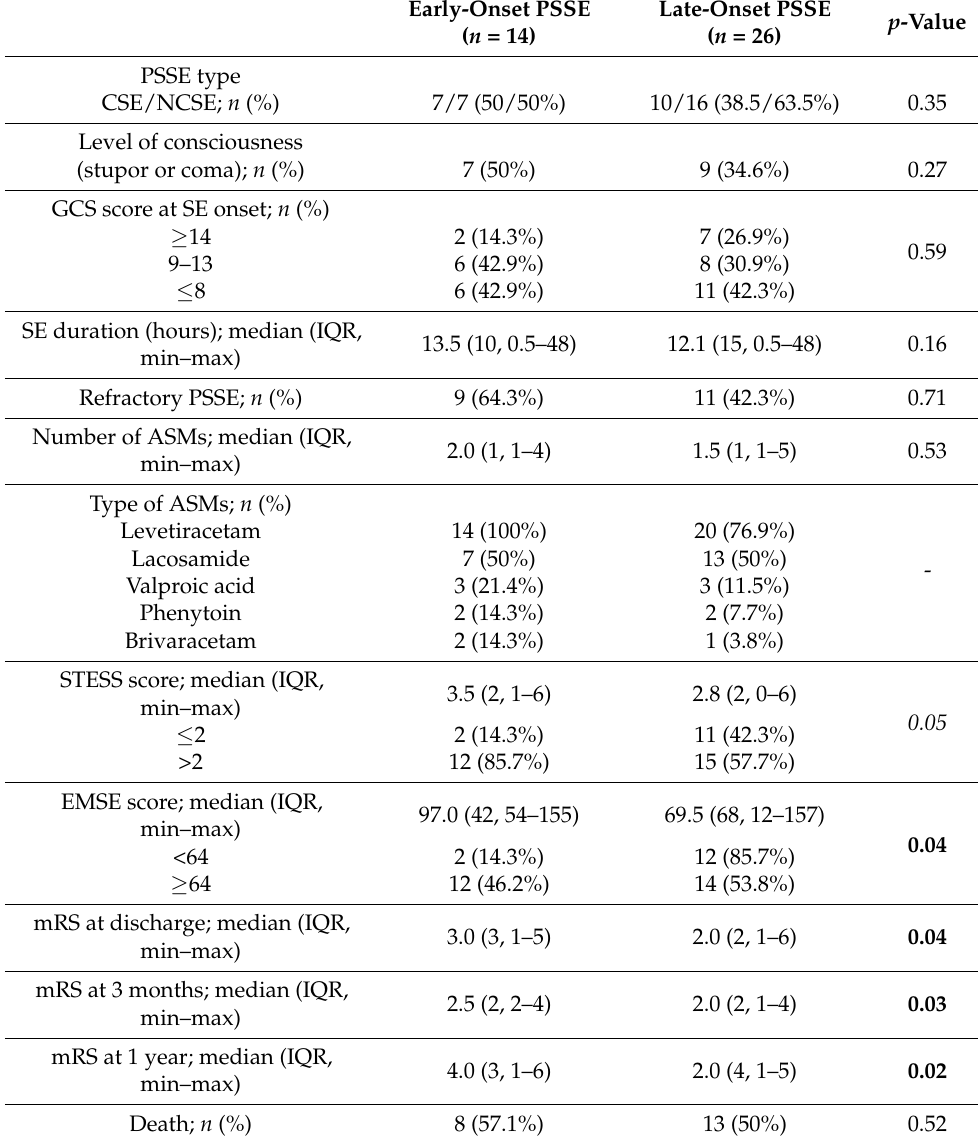
Table 3. Main characteristics of post-stroke status